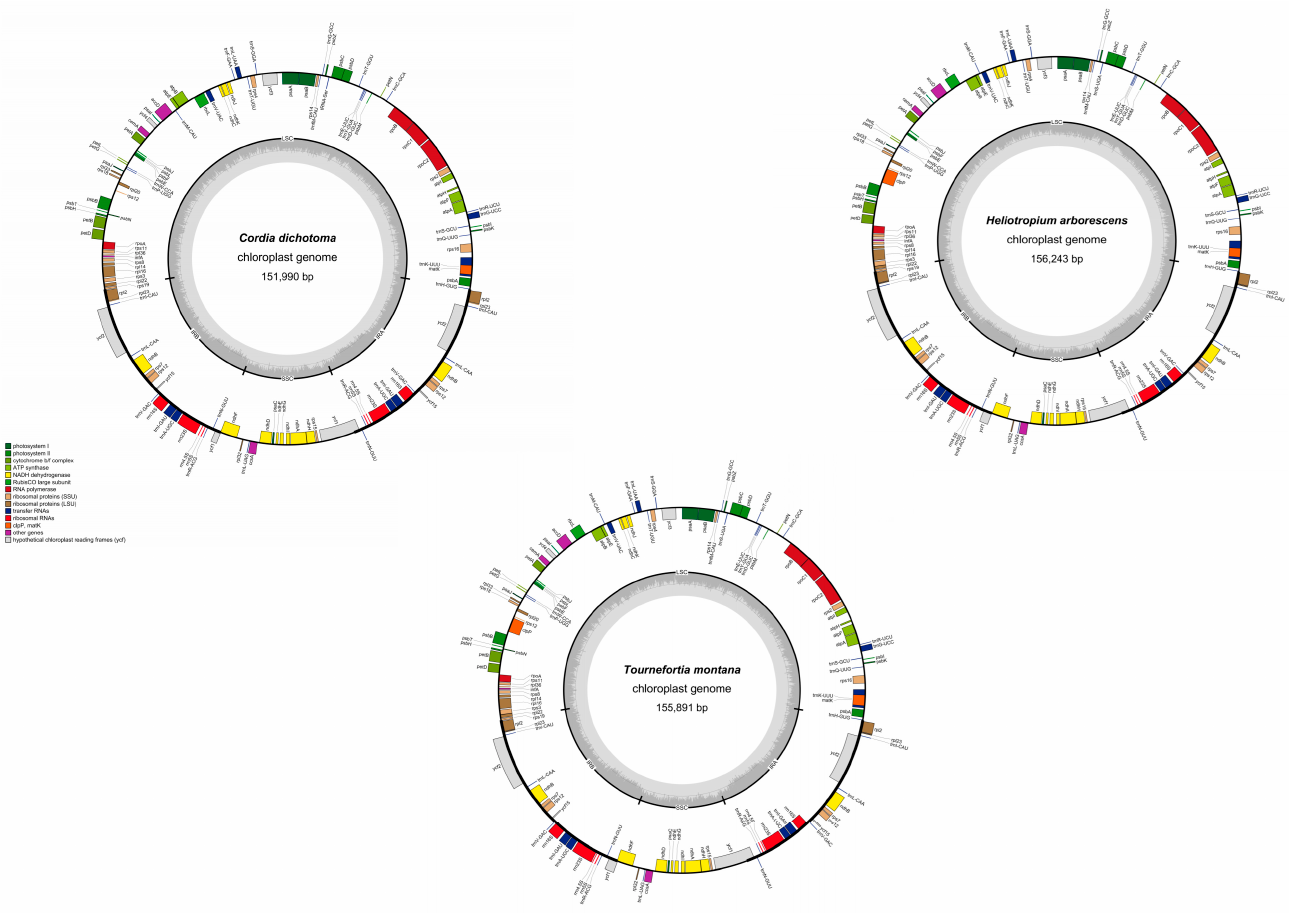
Figure 1. Plastid genome maps for Cordia dichotoma , Heliotropium arborescens , and Tournefortia montana